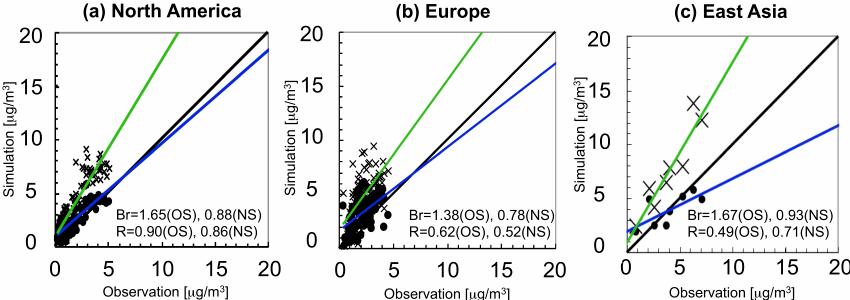
Fig. 5. Simulated and observed monthly mean surface mass concentrations of sulfate over (a) North America, (b) Europe and (c) East Asia. The black line represents 1:1 line between observations and the simulations. The blue and green lines represent linear regressions of the simulations in NS and OS, respectively. The B r and R 2 values in the figure represent a relative bias, defined as a ratio of simulation to observation, and a correlation coefficient, respectively. The x-axis values are month and the y-axis values are sulfate mass concentrations in µgm − 3 .